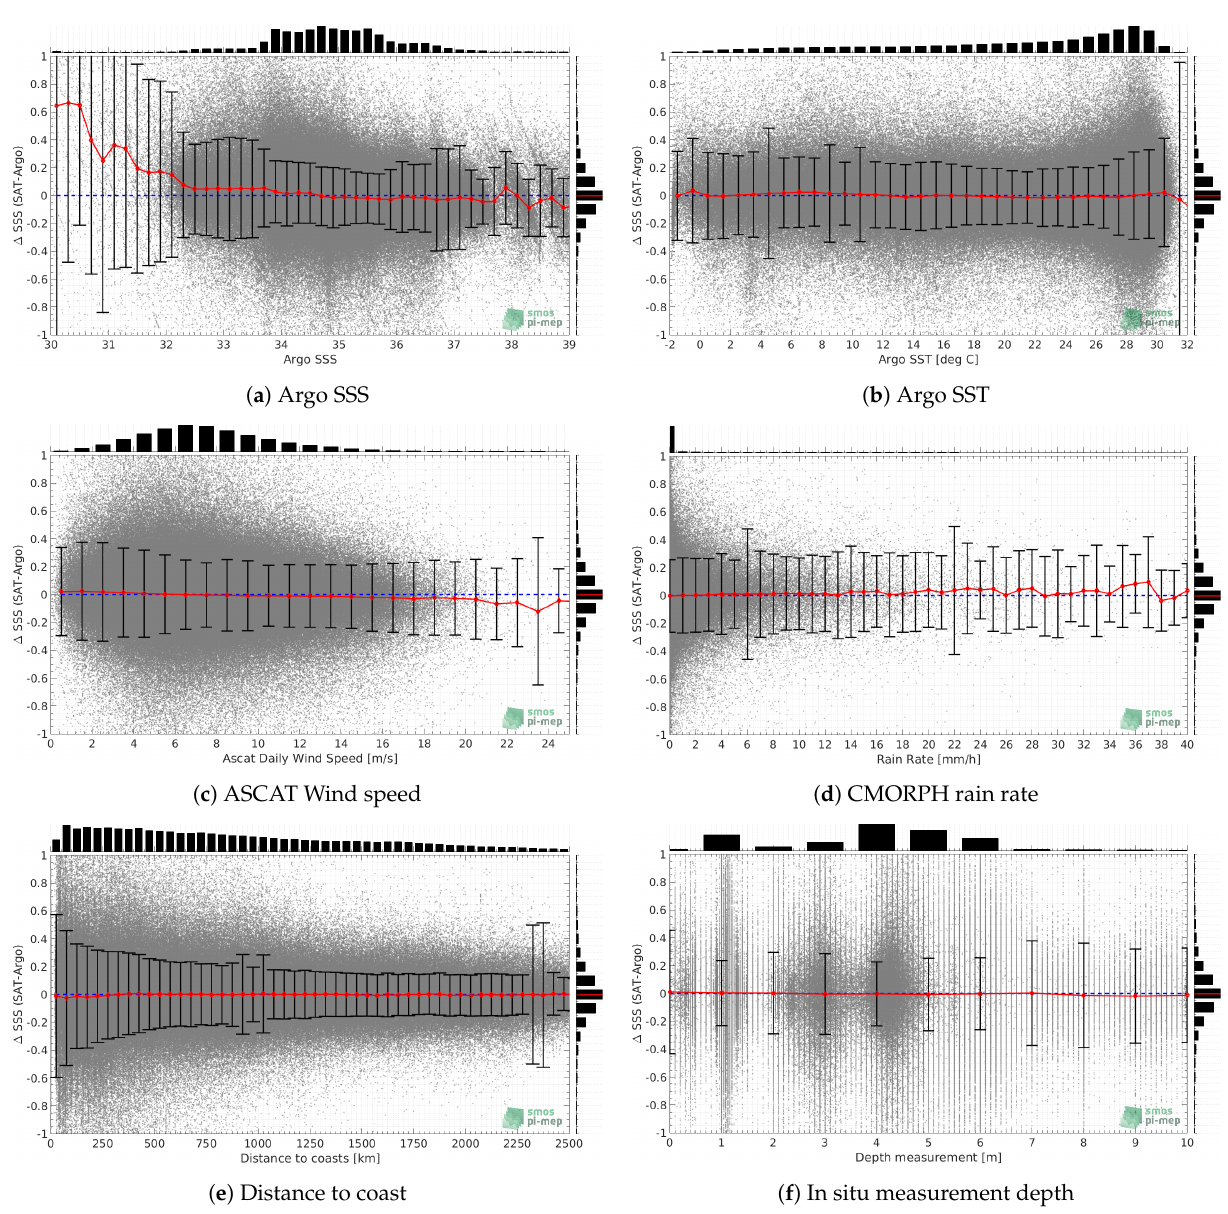
Figure 13. ∆ SSS (Satellite−Argo) sorted as function of Argo SSS values ( a ), Argo SST ( b ), ASCAT Wind speed ( c ), CMORPH rain rate ( d ), distance to coast ( e ) and in situ measurement depth ( f ). In all plots the median and STD of ∆ SSS for each bin is indicated by the red curves and black vertical thick bars ( ± 1 STD). Normalized marginal histograms are also indicated outside each